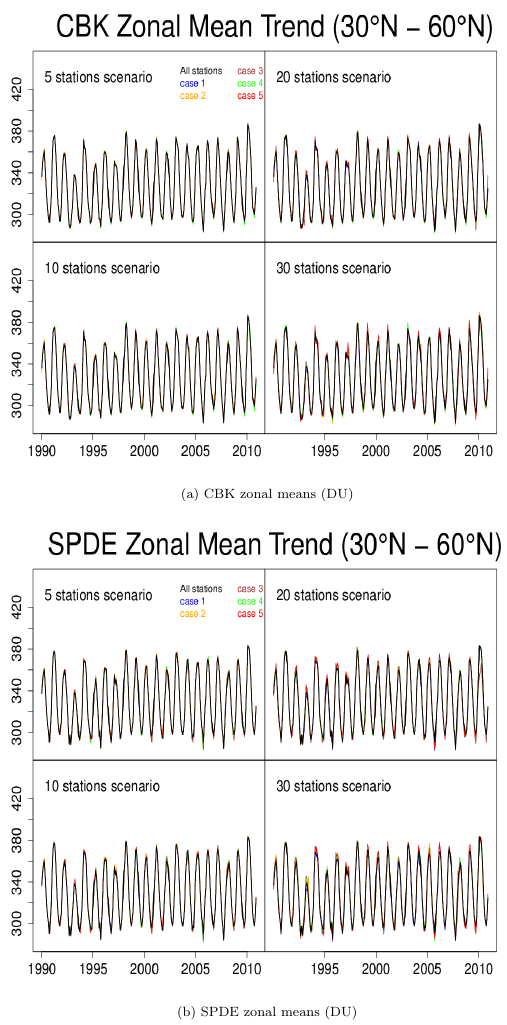
Figure 10. Time series of 30–60 ◦ S zonal means by (a) covariance- based kriging (CBK) and (b) SPDE from 1990 to 2010 for four scenarios with 5, 10, 20 and 30 stations removed globally including 1, 2, 4 and 6 stations removed in the